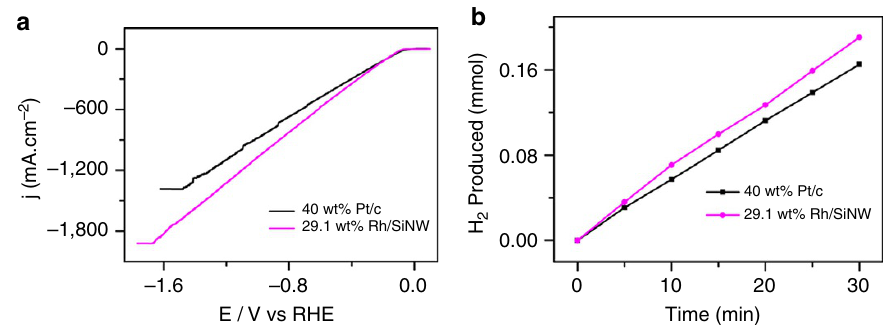
Figure 3 | HER relative efficiency of 29.1wt% Rh/SiNW and 40wt% Pt/C in oxygen-free 0.5M H 2 SO 4 . ( a ) LSV of both catalysts for high current densities. At 1,000mAcm (cid:2) 2 the electric power to hydrogen energy conversion efficiency of 29.1wt% Rh/SiNW is larger by 7.8%. Note that the current for 29.1wt% Rh/SiNW is more stable. ( b ) Hydrogen evolution by 29.1wt% Rh/SiNW and 40wt% Pt/C systems at (cid:2) 0.4V. The hydrogen evolution using 29.1wt% Rh/SiNW is larger by